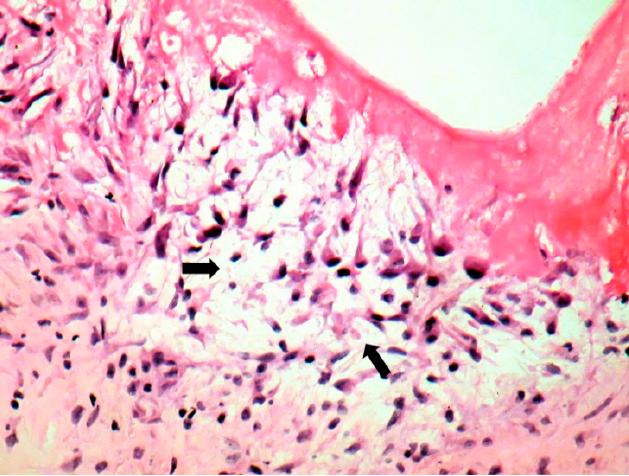
J. Pers. Med. 2021 , 11 , x FOR PEER REVIEW